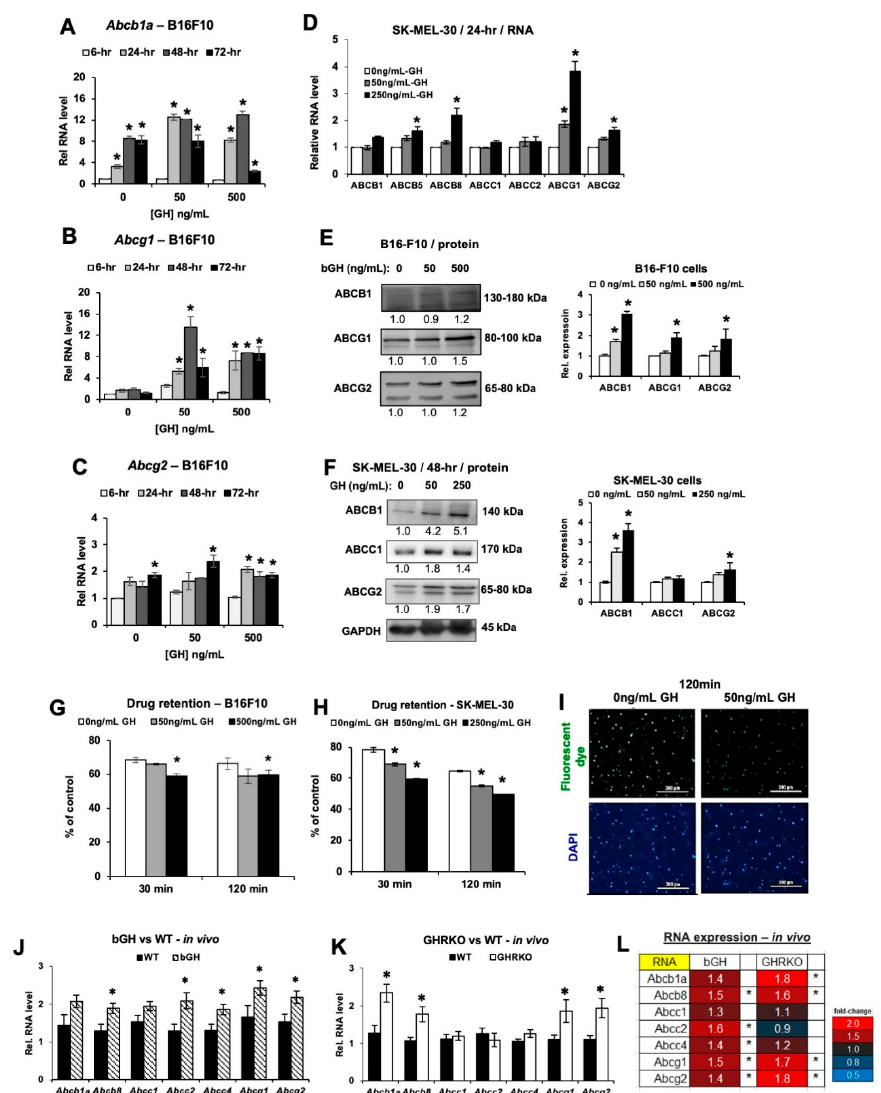
Figure 3. Changes in ABC e ffl ux pumps in B16-F10 mouse melanoma in vitro and in vivo. ( A – C ) Changes in RNA levels for Abcb1a , Abcg1 , Abcg2 in B16-F10 mouse melanoma cells treated with bGH, normalized against reference genes (n = 3). ( D ) Changes in RNA levels for several ABC e ffl ux pumps in SK-MEL-30 human melanoma cells treated with hGH for 24 h, normalized against GAPDH gene (n = 3). ( E ) Changes in proteins levels of several ABC e ffl ux pumps of B16-F10 cells treated with bGH for 72 h. Densitometry analysis was performed and normalized to total protein (n = 3). ( F ) Changes in proteins levels of several ABC e ffl ux pumps of SK-MEL-30 cells treated with hGH for 48 h, normalized to GAPDH (n = 3). ( G ) Drug retention was decreased in B16-F10 cells pretreated with bGH for 1 week (n = 3). ( H ) Similar results were found in SK-MEL-30 cells (n = 3). Data are presented as mean ± standard deviation (*, p < 0.05, Mann-Whitney U test). ( I ) Representative images for SK-MEL-30 cells with fluorescent dye (green) treated with and without 50 ng / mL hGH for 1 week (20 × magnification; scale bar represents 300 µ m). ( J ) Relative RNA levels for seven di ff erent ABC e ffl ux pumps in B16-F10 tumors grown in vivo in bGH and WT mice, normalized against reference genes (both sexes combined). bGH mice (n = 12), WT mice (n = 12). ( K ) Relative RNA levels for seven di ff erent ABC e ffl ux pumps in B16-F10 tumors grown in vivo in GHRKO and WT mice, normalized against reference genes (both sexes combined). GHRKO mice (n = 10), WT mice (n = 13). ( L ) Heatmap showing the variations in RNA expression of ABC e ffl ux pumps in tumors in bGH or GHRKO mice (both sexes combined). Data are presented as mean ± standard error (*, p < 0.05, unpaired student’s t